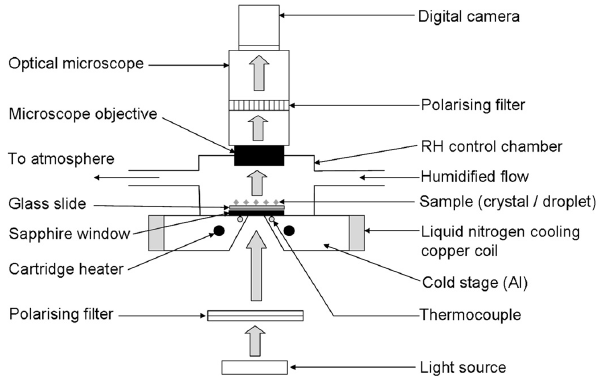
Fig. 1. Schematic depiction of the experimental set-up used to study the deliquescence of crystalline particles and the efflorescence of aqueous solution droplets.